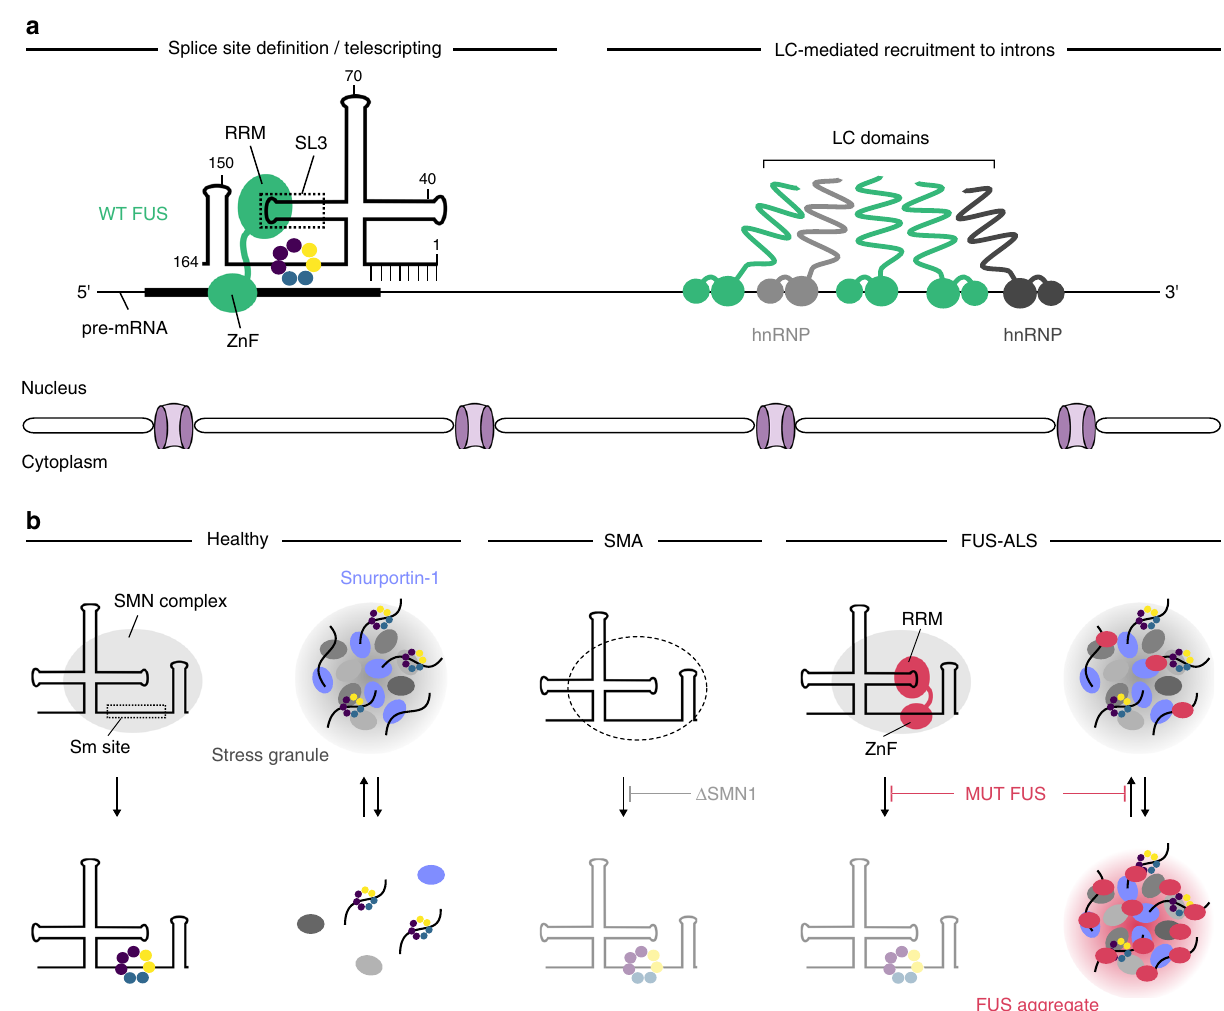
Fig. 6 Bipartite interactions at the core of FUS ’ role in physiology and disease. a In the nucleus, the RRM domain of FUS contacts the U1 snRNP at stem- loop 3, which positions the zinc- fi nger domain to interact with the pre-mRNA. Such intermolecular bipartite interactions could help to position the U1 snRNP on pre-mRNA to de fi ne 5 ’ -splice sites and suppress premature polyadenylation. The LC domain of FUS allows FUS to interact with hnRNPs and promotes its recruitment to introns. b In the cytoplasm, U1 snRNPs undergo maturation with the SMN complex loading the Sm ring onto the snRNA. In SMA, this assembly activity is impaired due to insuf fi cient amounts of the SMN protein. ALS-associated FUS engages in an aberrant intramolecular bipartite interaction with the U1 snRNA and interferes with core snRNP assembly in a toxic gain-of-function manner. Upon cellular stress, core snRNPs are sequestered into stress granules which may mature into the irreversible FUS aggregates observed in